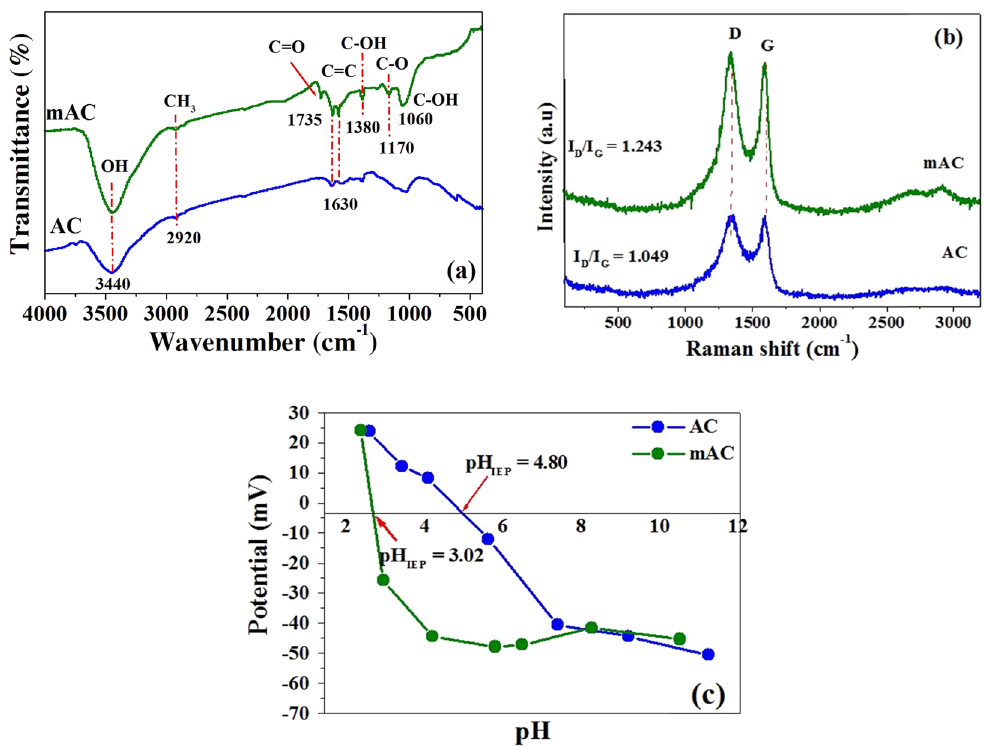
Figure 2: ( a ) FT - IR spectra, ( b ) Raman spectroscopy, and ( c ) zeta potential curves of AC and